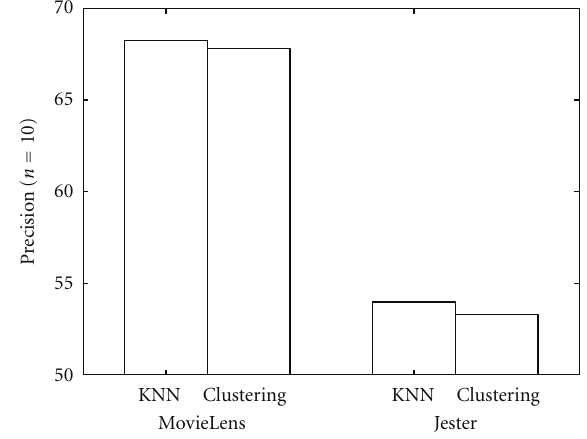
Figure 3: Precision values on MovieLens and Jester when using KNN and clustering approaches for neighbors selection, when ratings are